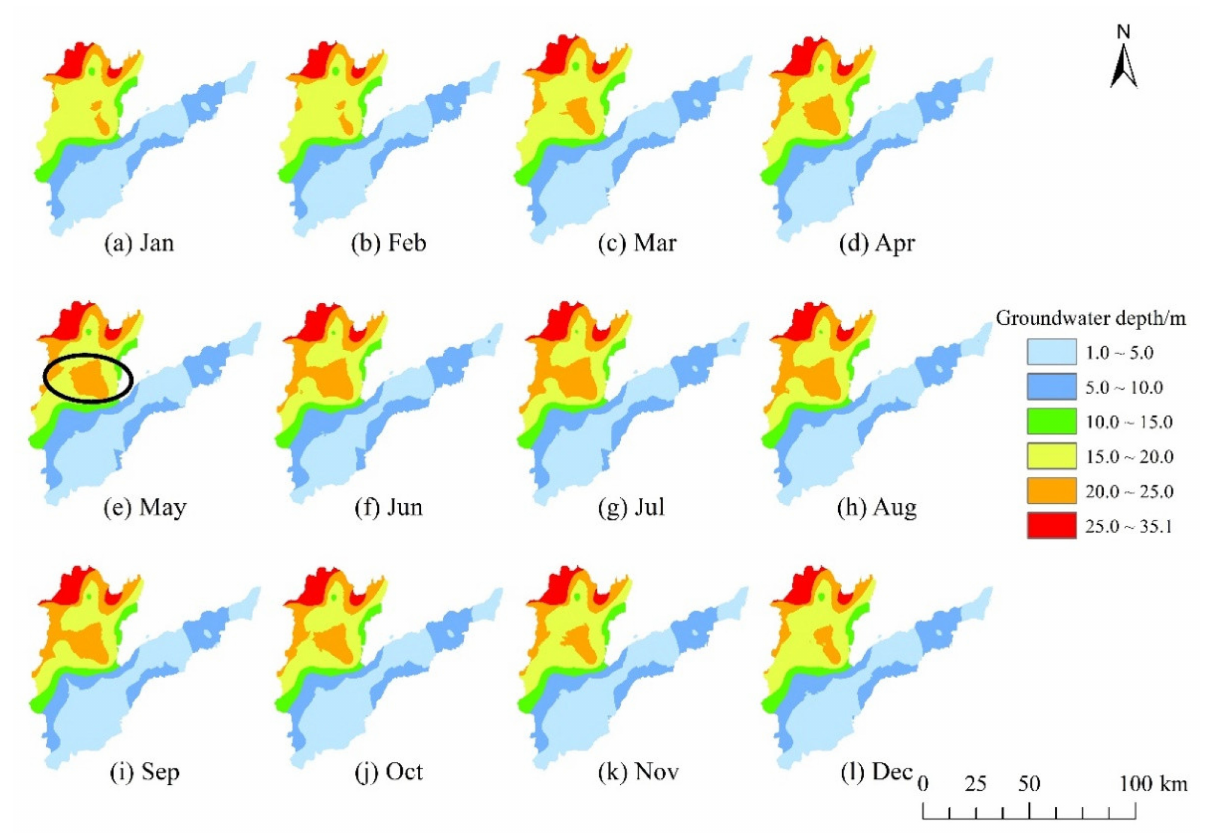
Figure 5. Distribution of the mean buried depth of the groundwater in Puyang area for each month during the period of